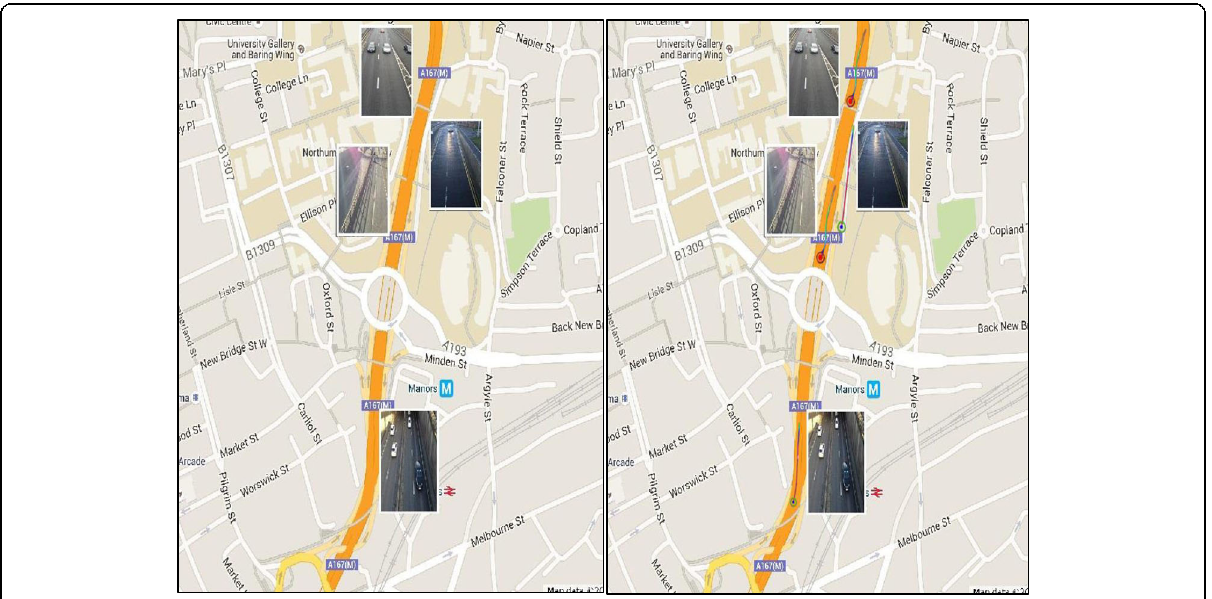
Fig. 23 Time-stamped glyph-based visualization of various videos